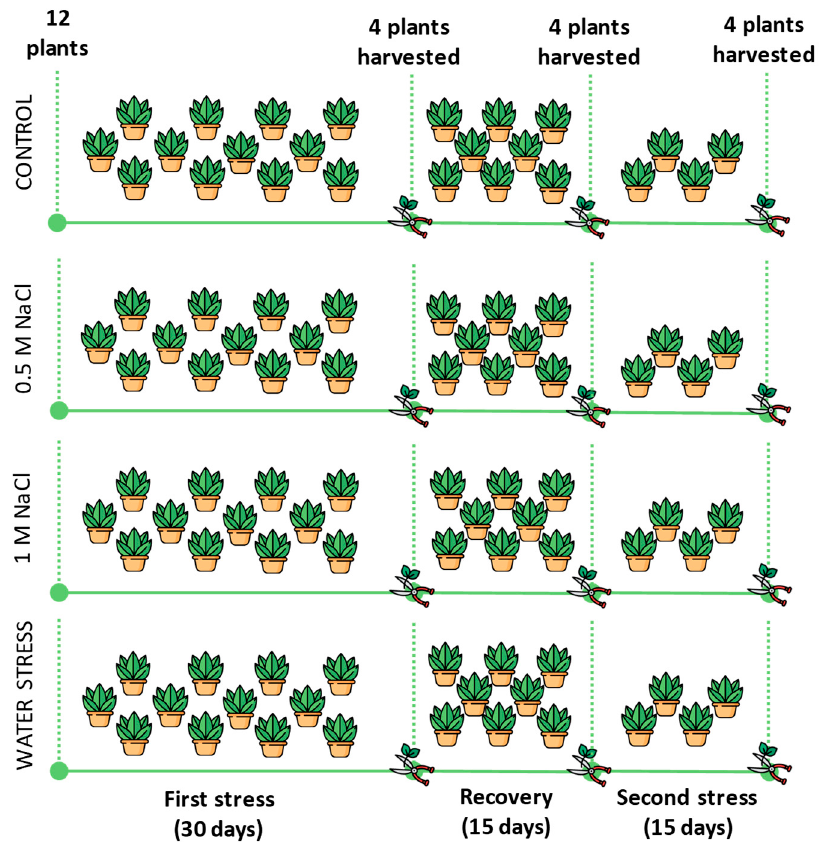
Figure 9. Scheme of the experimental phases: 12 plants were prepared for each of the four treatments (Control, 0.5 M NaCl, 1 M NaCl, Water stress). After 30 days of stress exposition (First stress), 4 plants per treatment were harvested, and the remaining 8 plants were allowed to recover for the next 15 days (Recovery). After that, another four plants were harvested and the remaining four were subjected to a further 15 days of stress before the final harvest.